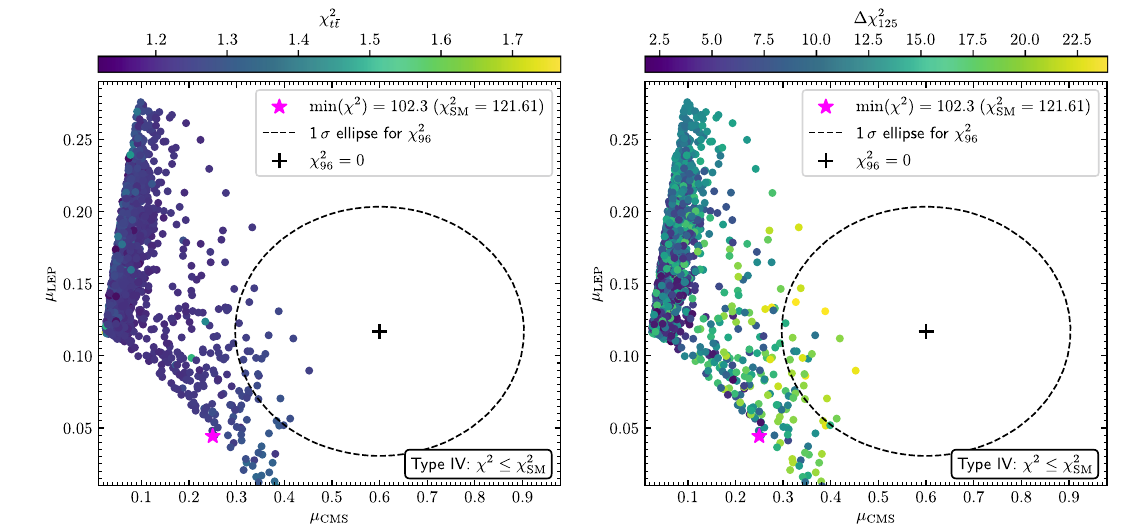
Fig. 20 The μ CMS – μ LEP plane for the points of the low tan β scan in the type IV of the N2HDM. The black ellipse indicates the 1 σ region of χ 2 with its center marked with a black cross. The best-fit point is 96